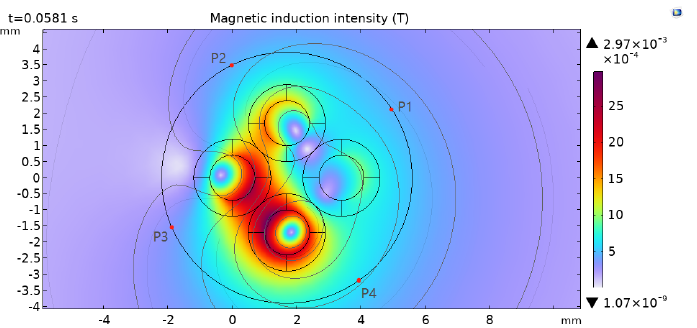
Figure 5. Distribution diagram of magnetic induction intensity under asymmetric current when the deflection angle is 30 ◦ at t = 0.0581.